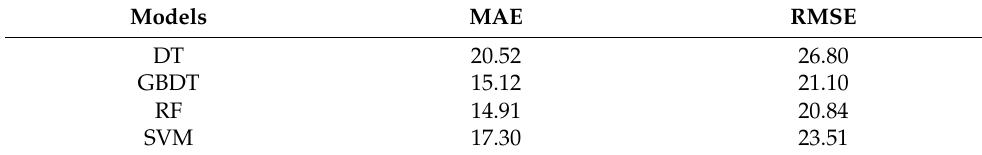
Table 5. Results of the various machine learning algorithms on test set.